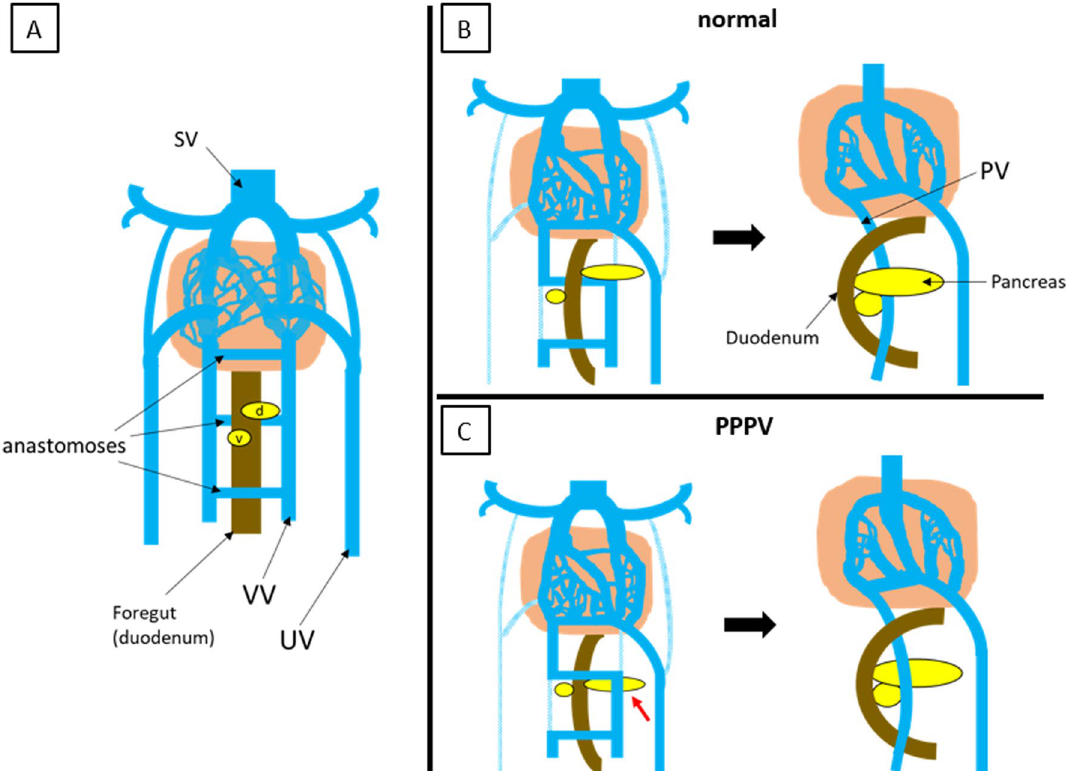
Fig. 6 Development of the portal vein. A Paired vitelline veins are connected by three anastomoses. The duodenum lies ventral to the intermediate anastomosis. The dorsal pancreatic bud arises ventrally to the left vitelline vein, and the ventral pancreatic bud arises contralateral and slightly caudal to the dorsal pancreatic bud. B Normal development of portal vein and pancreas. The lower part of the right vitelline vein and the upper part of the left vitelline vein disappear, and the intermediate anastomosis on the dorsal side of the duodenum forms the portal vein main trunk. As the duodenum rotates, the ventral pancreatic bud fuses behind the dorsal pancreatic bud. C Development of the prepancreatic postduodenal portal vein. The dorsal pancreatic bud arises on the dorsal side of the left vitelline vein, or arises caudal to the intermediate anastomosis, which results in the portal vein posterior to the duodenum but anterior to the pancreas. SV sinus venosus, d dorsal pancreatic bud, v ventral pancreatic bud, VV vitelline vein, UV umbilical vein, PV portal vein, PPPV prepancreatic postduodenal portal